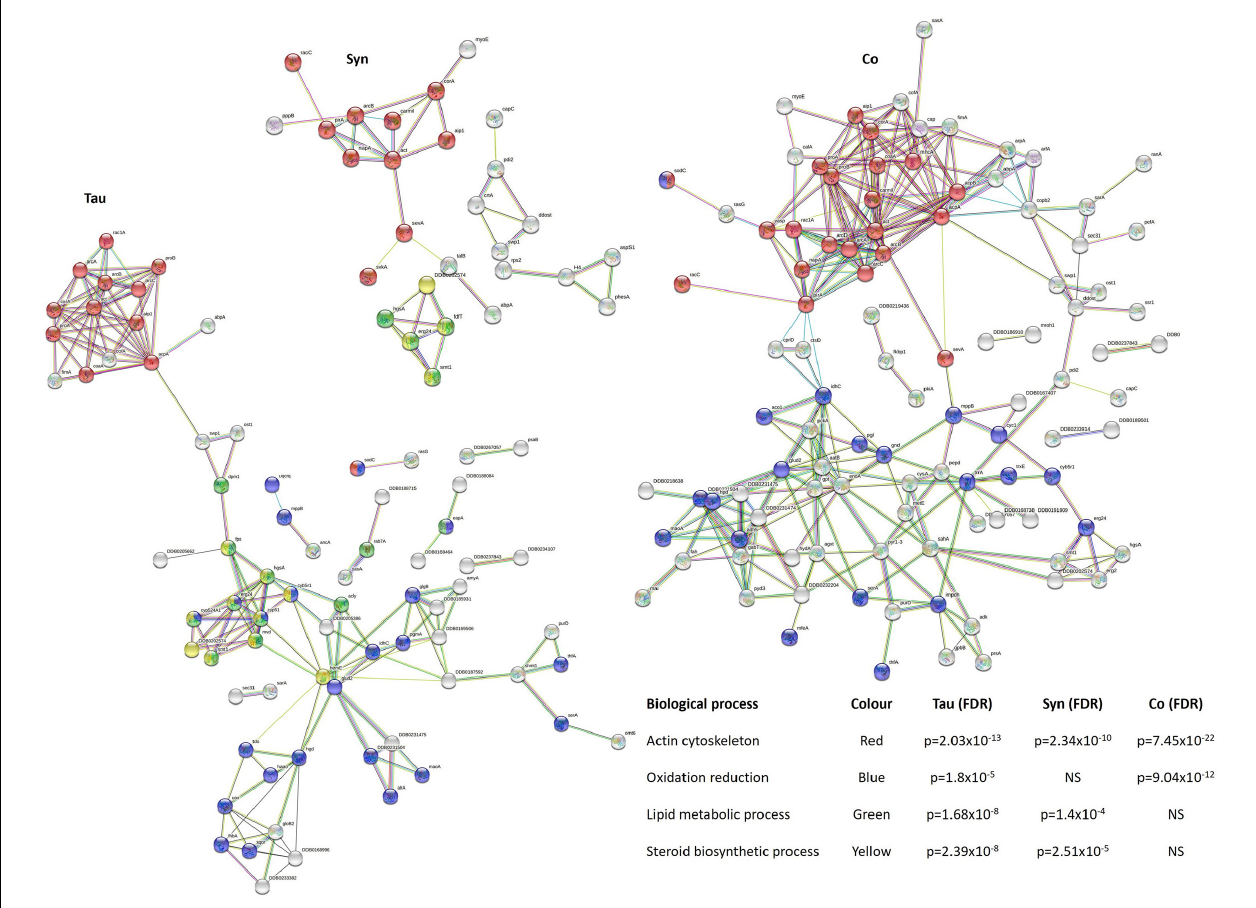
FIGURE 11 | Down-regulated biological processes in strains expressing tau and/or α -synuclein. To give a visual representation of protein groups, STRING was used to view the interacting protein clusters in the main processes down-regulated in the tau, α -synuclein, and cotransformants and calculate False Discovery Rates (FDR) which indicate statistical significance of the overrepresentation of these processes in the list of interacting proteins. Proteins and STRING protein annotations can be found in Supplementary Tables 2, 4, 6